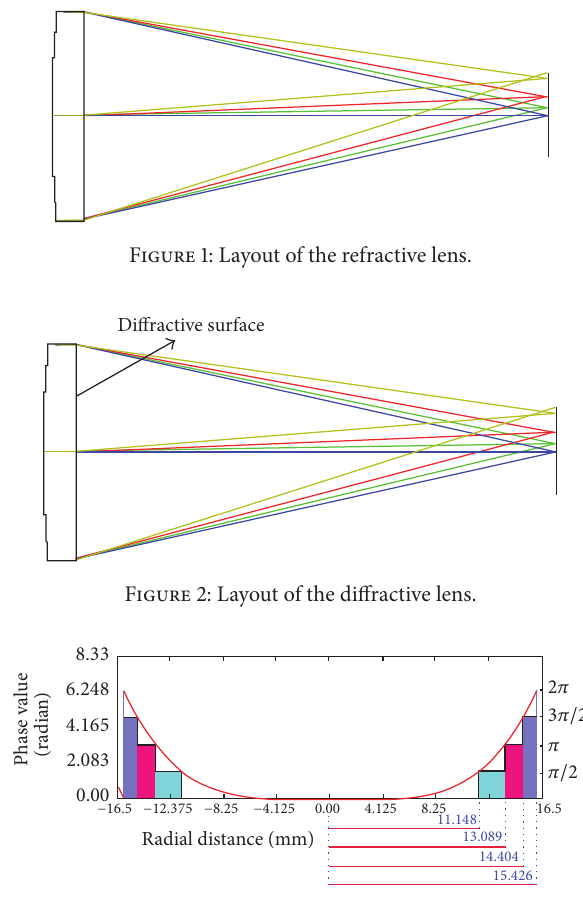
Figure 3: Phase curve versus aperture of the diffractive surface slicing into 2 𝜋 layers and the discrete phase